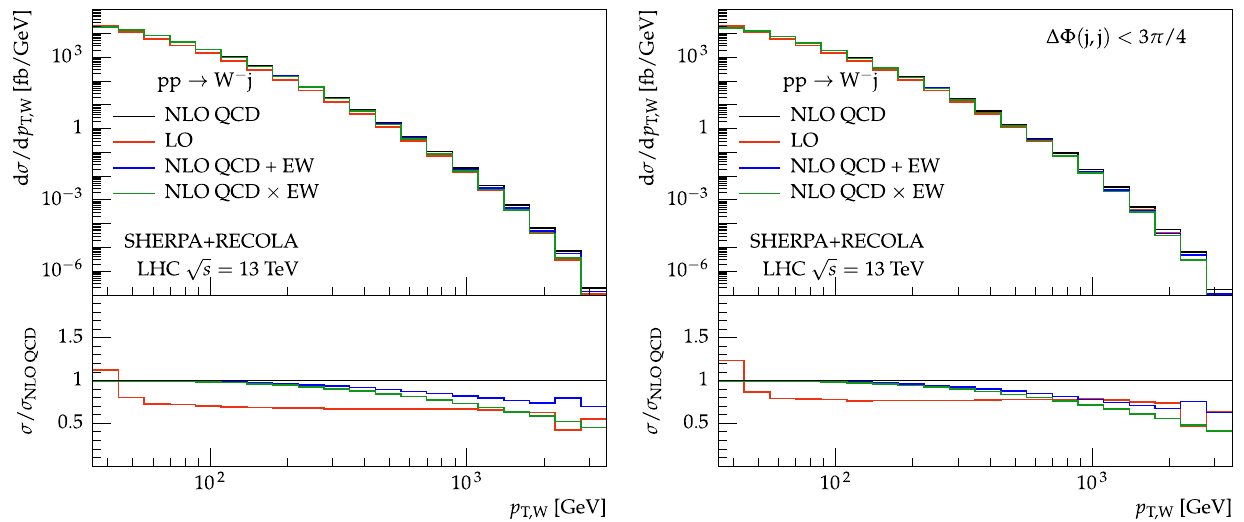
Fig. 10 Differential distributions at 13TeV for on-shell W + j production at the LHC. The left-hand plot shows the p T of the W boson with minimal cuts and the right-hand plot the result with a cut of (cid:5)(cid:12)( j , j ) < 3 π/ 4, as in Fig.